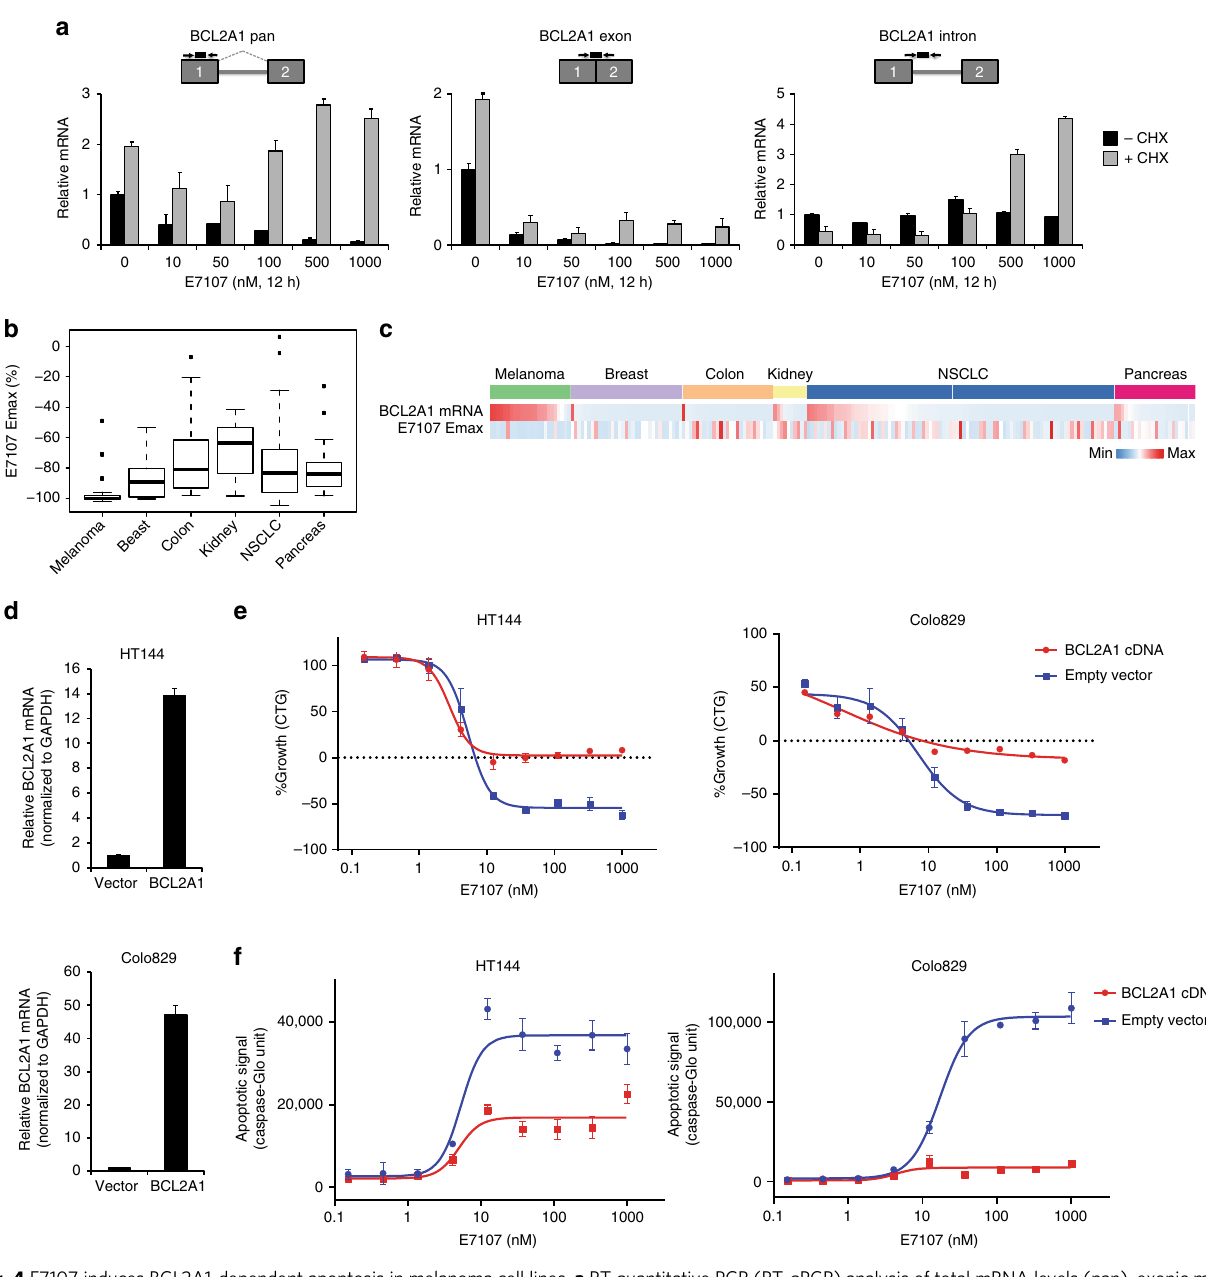
Fig. 4 E7107 induces BCL2A1-dependent apoptosis in melanoma cell lines. a RT quantitative PCR (RT-qPCR) analysis of total mRNA levels (pan), exonic mRNA levels covering the junction of exons (exon), and pre-mRNA levels detecting the intron (intron) of BCL2A1 . HT144 cells were pre-treated with 100 µ gml − 1 cycloheximide (CHX) for 1h, followed by addition of E7107 as indicated for 12h to inhibit nonsense-mediated mRNA decay (NMD) before collecting RNA samples. Schematic representations of TaqMan primers and probes were shown. Boxes: exons; gray lines: introns; arrows: primers; and black lines: probes. b Box plots showing the distribution of E7107 Emax in the solid tumor cell lines separated by tissue/lineage: melanoma ( n = 24), breast ( n = 33), colon ( n = 27), kidney ( n = 10), lung ( n = 91), and pancreas ( n = 24). The box plots exhibit fi ve number summary from bottom to top: minimum, fi rst quartile, median, third quartile, and maximum/outliers. c Heatmap of BCL2A1 mRNA expression (based on CCLE RNA-seq, sorted from high to low in the solid tumor cell lines separated by tissue/lineage) and E7107 Emax. d RT-qPCR analysis of BCL2A1 mRNA levels (exon1/2 junction) in vector control (Vector) or stable BCL2A1 cDNA-expressing (BCL2A1) melanoma cell lines. Data represent means±SD of biological triplicates. e Growth curves measured by CellTiter-Glo (CTG) and f apoptosis induction curves measured by IncuCyte Caspase-3/7 Green Apoptosis Assay in melanoma cell lines stably transduced with vector control (empty vector) or BCL2A1 cDNA (BCL2A1 cDNA) treated with E7107 for 72h. Data represent means±SD of biological